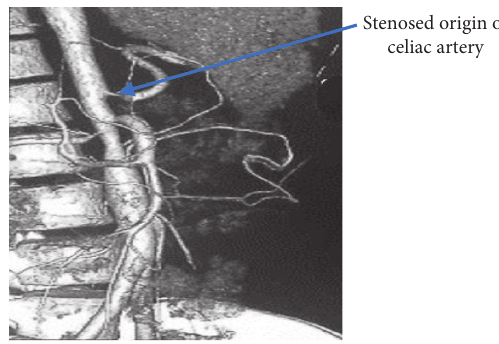
Figure 1: CTA showing the stenosed origin of the celiac artery.